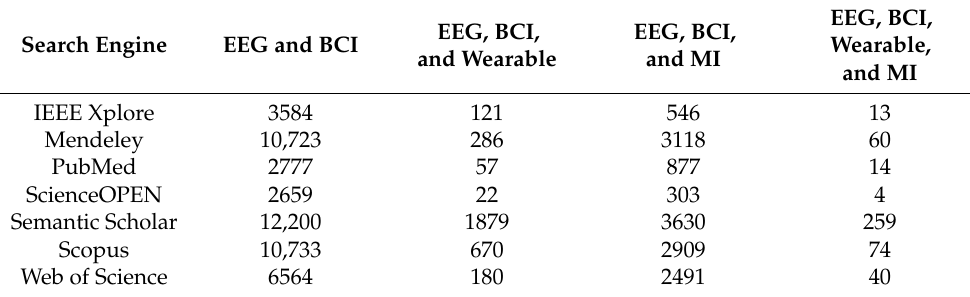
Table 2. Summary of the searches considering keyword subsets. The fields present the search engines and the main keywords related to the considered